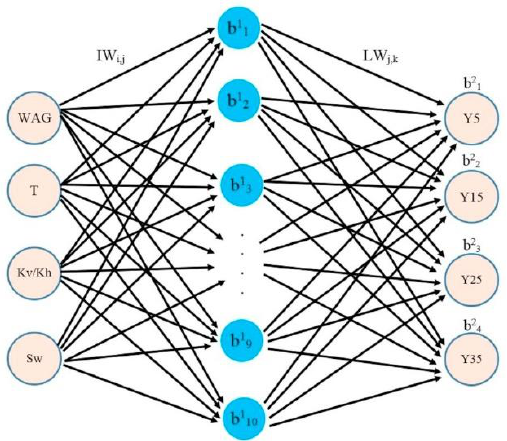
Figure 15. Artificial neural network structure of the models, Y represents oil recovery, oil production rate, gas and oil ratio (GOR), and net CO 2 storage amount [221]. rate, gas and oil ratio (GOR), and net CO 2 storage amount